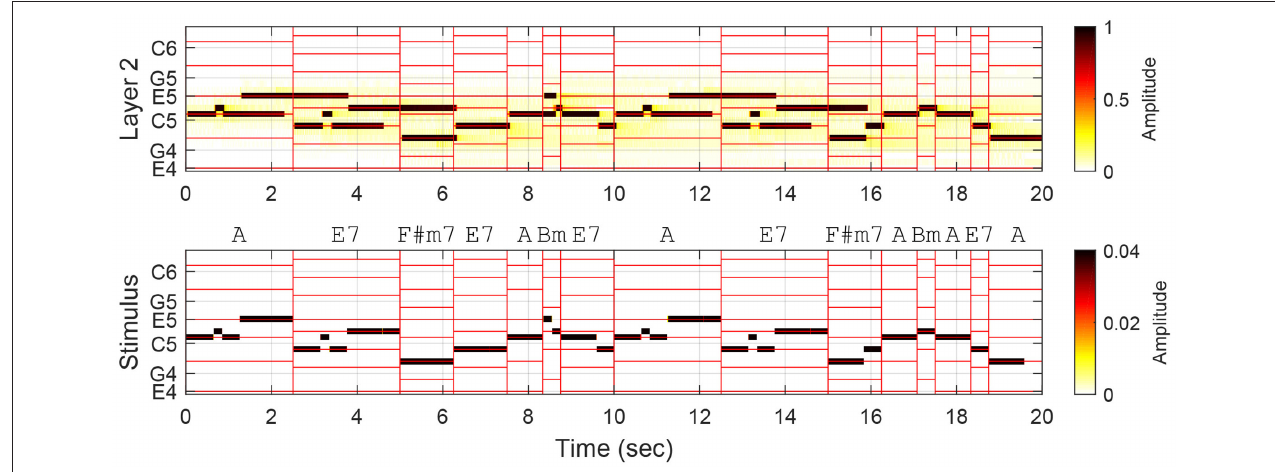
FIGURE 4 | Oscillatory traces formed in Layer 2 in response to the first two phrases (the first 15 chord spans) in Mozart Piano Sonata No. 11, K. 331, Theme. Vertical red lines demarcate chord spans, and horizontal lines indicate the pitches belonging to the chords. Chord annotations are based on both the melody and the